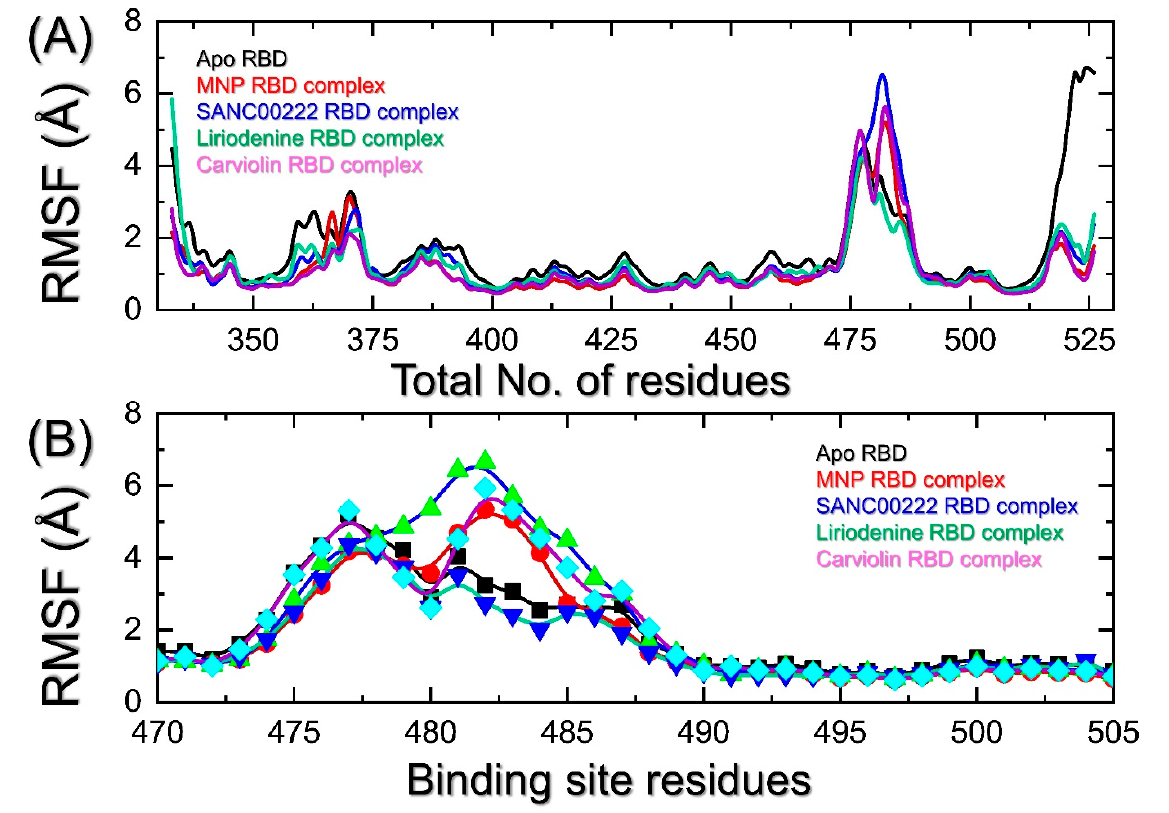
Figure 7. Calculation of residues' flexibilities in a dynamic environment. ( A ) shows the RMS f patterns for all the complexes, while ( B ) show the RMS f pattern for region 470–505.